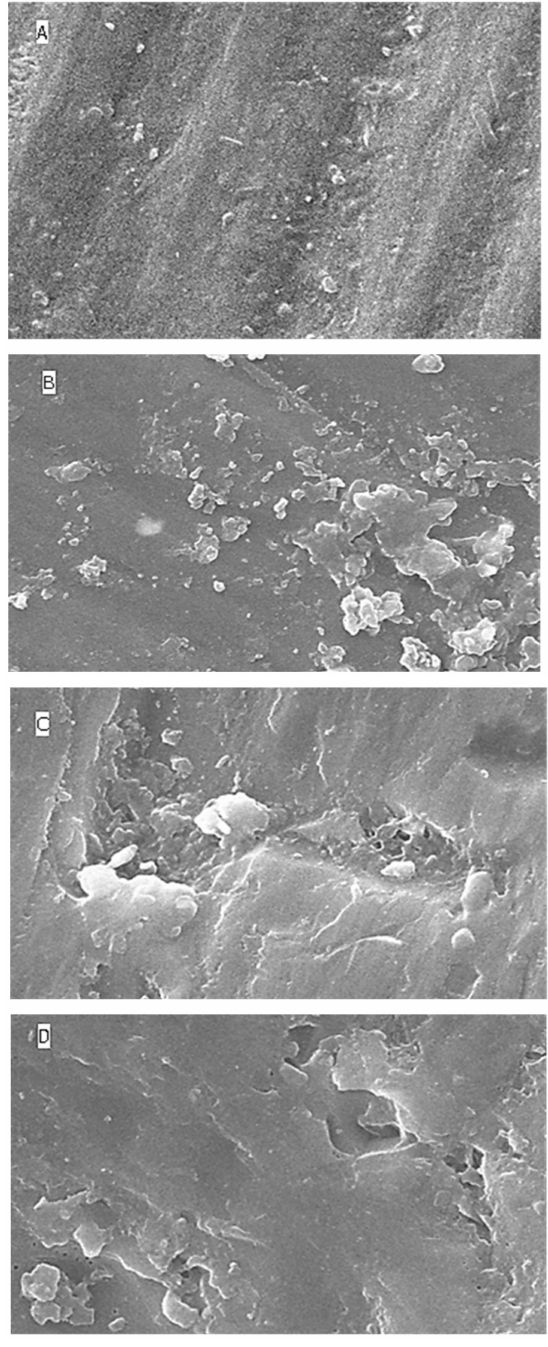
Figure 8. SEM images ( A – D ) of surface roughness at baseline, 24 h, 96 h and 168 h in soft cola. ( A ): Baseline SEM photomicrograph of IPS e.max ceramic before immersion in cola ( × 5000). ( B ): SEM photomicrograph of IPS e.max ceramic after 24 h immersion in cola ( × 5000). ( C ): SEM photomicro- graph of IPS e.max ceramic after 96 h immersion in Cola ( × 5000). ( D ): SEM photomicrograph of IPS e.max ceramic after 168 h immersion in Cola ( ×